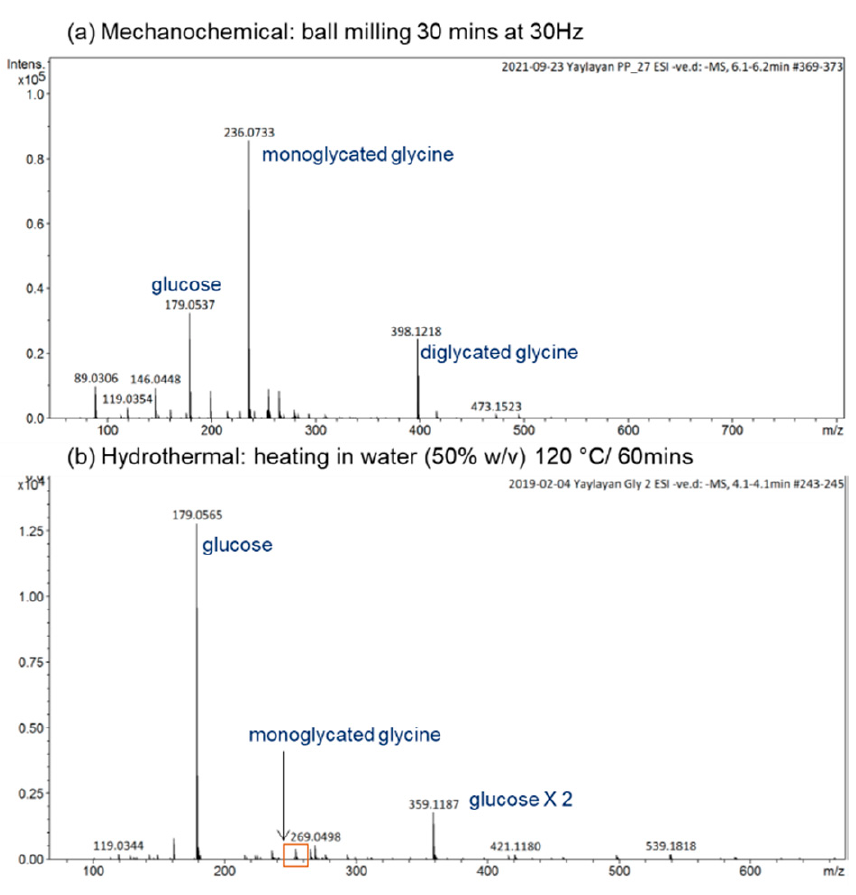
Figure 2. Comparison of the ESI( − ve)/MS spectra of the reaction mixtures of glycine/glucose (1:1) generated under ( a ) mechanochemical or ( b ) hydrothermal conditions. All identified ions are deprotonated [M − H] −